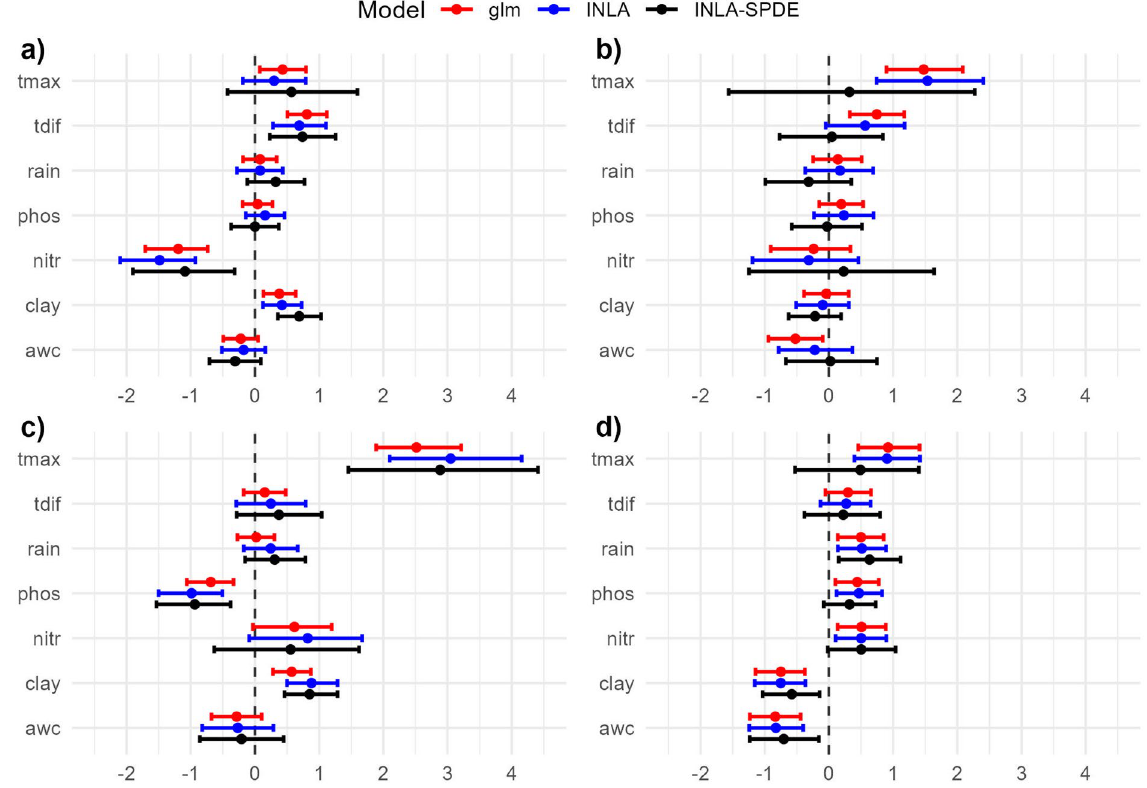
Figure 2. Model parameter estimates (estimates of standardised effect size or model beta coefficients 12 ) for climatic and edaphic variables on the probability of species presence based on the global (continent-scale) dataset for ( a ) A. pectinata , ( b ) B. ewartiana , ( c ) D. fecundum , and ( d ) T. triandra . Error bars are 95% confidence intervals for glm and 95% credible intervals for INLA and INLA-SPDE. Positive effect sizes indicate that the parameter increases the probability of species presence, while a negative effect indicates the opposite (see Table 2 for variable abbreviations used on the